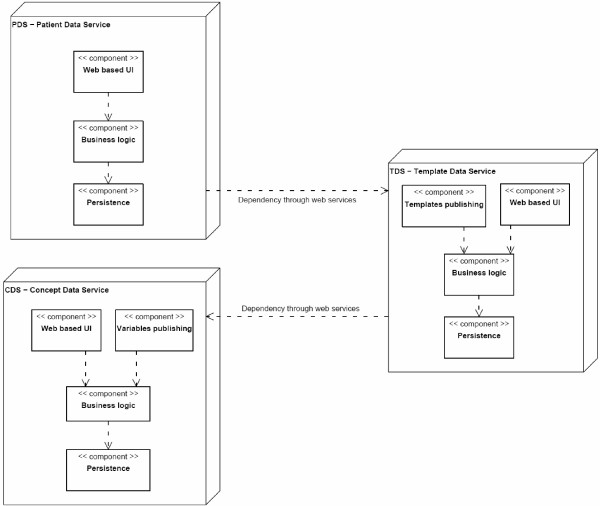
System Architecture Overview.